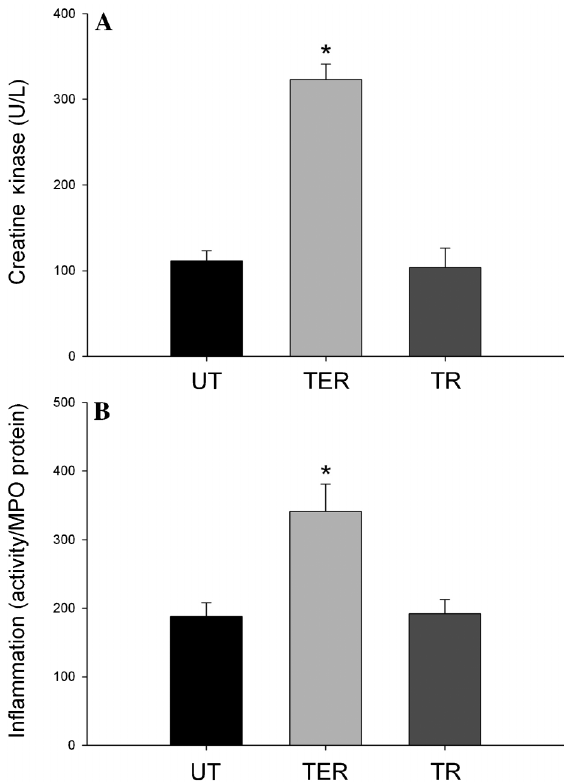
Figure 4. Muscle damage ( A , creatine kinase) and inflammation ( B , myeloperoxidase, MPO) levels were determined in skeletal muscle (red portion - quadriceps) 48 h after the last training session. The animals were divided into 3 groups (N = 6 each): UT = untrained; TER = trained eccentric running (16 ˚ ); TR = trained running (0 ˚ ). Data are reported as means ± SE. *P , 0.05 compared to the UT group (Tukey HSD